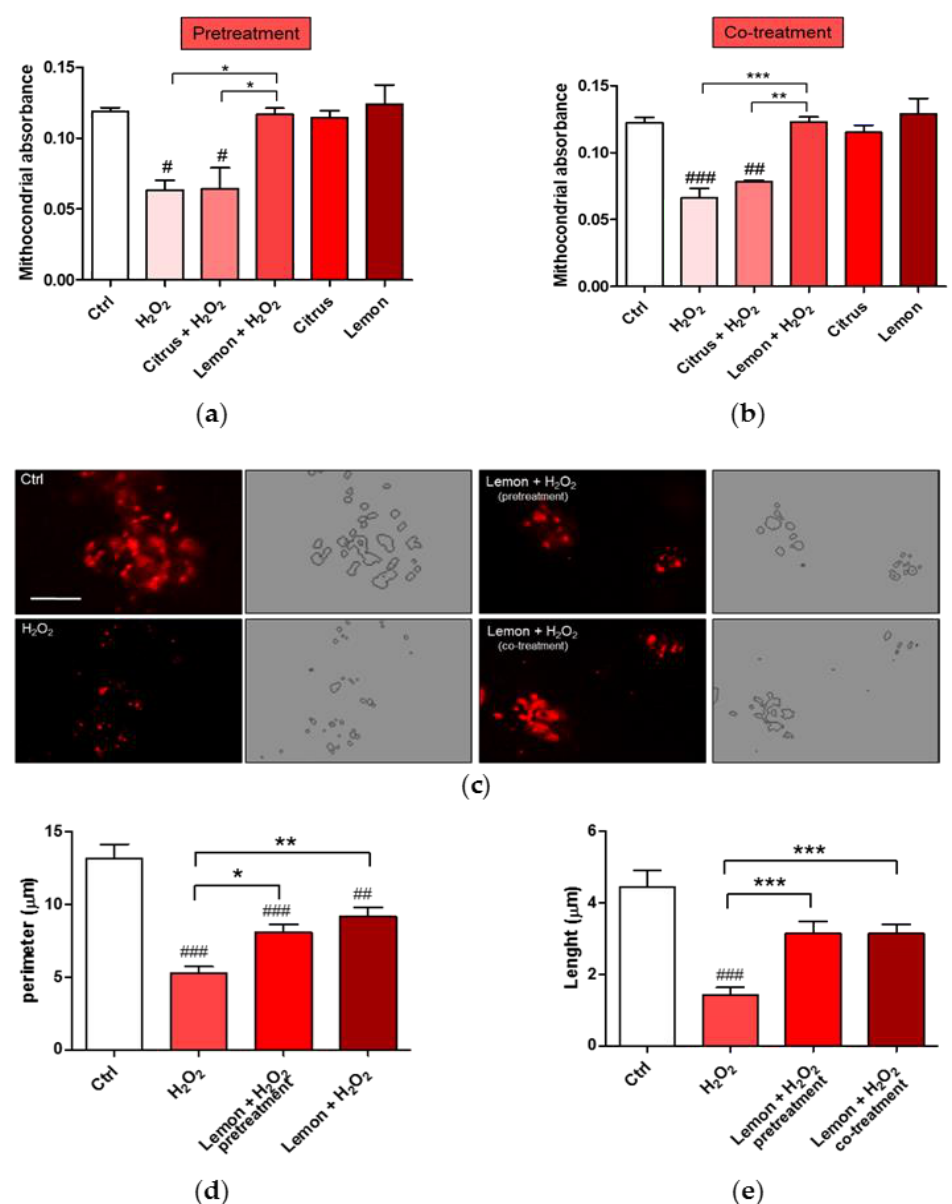
Figure 6. Effects of commercial (citrus) and lemon IntegroPectin (lemon) pectins on mitochondrial morphology and remodeling affected by exposure to aqueous H 2 O 2 : ( a ) Mitochondria remodeling of the pretreatment of untreated cells (Ctrl) or treated with pectins or with H 2 O 2 alone or in combination with pectins; ( b ) Mitochondria remodeling of the co-treatment of untreated cells (Ctrl) or treated with pectins or with H 2 O 2 alone or in combination with pectins; ( c ) Representative fluorescence microscopy images of mitochondria stained with the MitoTracker Deep Red in untreated cells (Ctrl) or treated with H 2 O 2 alone or in combination with lemon IntegroPectin (pretreatment and co-treatment); ( d , e ) Histograms representing quantification of mitochondria perimeter and length, respectively, in untreated cells (Ctrl) or treated with H 2 O 2 alone or in combination with lemon IntegroPectin (pretreatment and co-treatment). Bar: 50 µ m. Tukey test: # p < 0.05, ## p < 0.01, ### p < 0.001 as compared to control (Ctrl) group; * p < 0.5, ** p < 0.01, *** p <